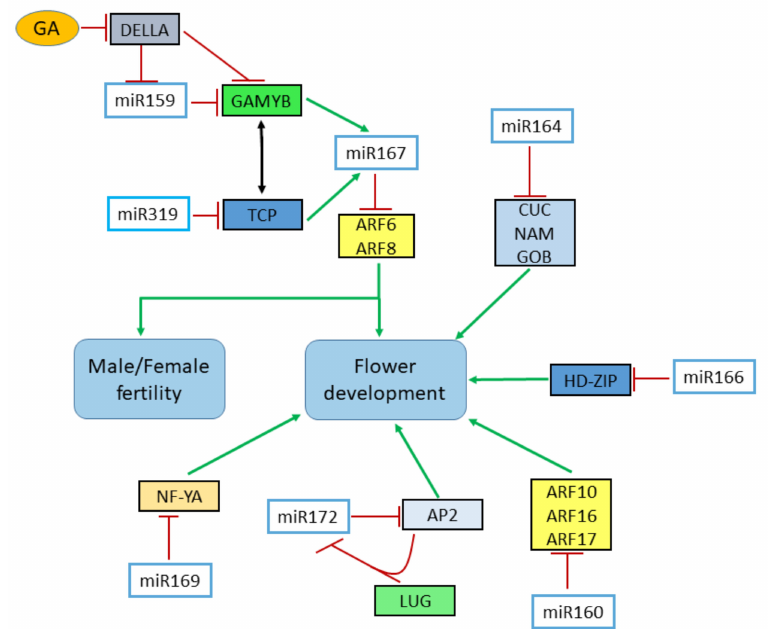
Figure 3. Analysis of di ff erent miRNA families and their target genes involved in genes in setting boundaries, flower development, and male / female fertility. MiR319 and miR159 and their target TCP proteins and GAMYB interact with miR167 and in return down-regulates the level of ARF6 and ARF8. GA treatment causes the down-regulation of both miR159 and GAMYB transcription factors through the degradation of DELLA proteins. MiR160 represses the expression of ARF genes which ultimately contribute to flower development. ARF, AUXIN RESPONSE FACTOR; GA, Gibberellic acid; CUC, CUP-SHAPED COTYLEDON; AP2, APETELA 2; GOB, GOBLET; LUG, LEUNIG; LFY, LEAFY; NAM, NO APICAL MERISTEM; NF-Y, NUCLEAR FACTOR